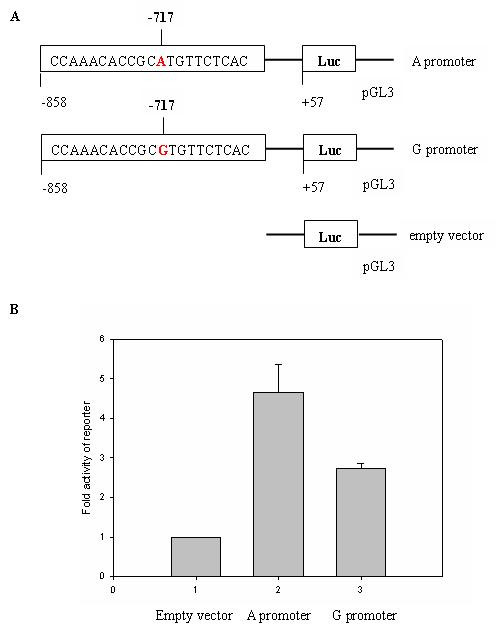
Allelic change from G (nonsusceptible allele) to A (susceptible allele) at the site of rs2794521 located in the promoter of CRP gene enhanced transcriptional activity of the promoter of CRP in HepG2 cells. A, schematic representation of the plasmid constructs. 915 bp fragment of CRP promoter (-858/+57) containing either the A or G allele (i.e. A and G promoter, respectively) was inserted in the pGL3-basic luciferase expression vector. Empty vector: pGL3-basic vector. B, HepG2 cells were contransfected with individual firefly luciferase (FLuc)expressing plasmid (A promoter, G promoter, empty vector) and pRL-TK as described in Materials and Methods. Cells were harvested after 24 hours, and relative luciferase activity (FLuc/Renilla luciferase) was determined. Fold luciferase activity of the variant A construct was 1- to 2-fold higher than that of the common G construct (P < 0.005). Data are present as fold-induction compared with promoter vector without insert. Bares are mean ± standard error of 3 different experiments, each performed in dulplicate.